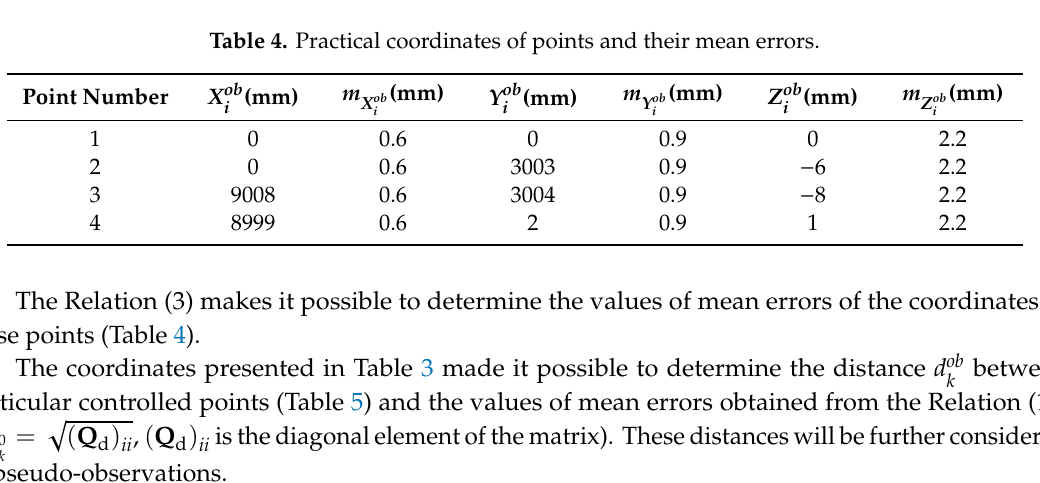
Table 5. Distances d ob